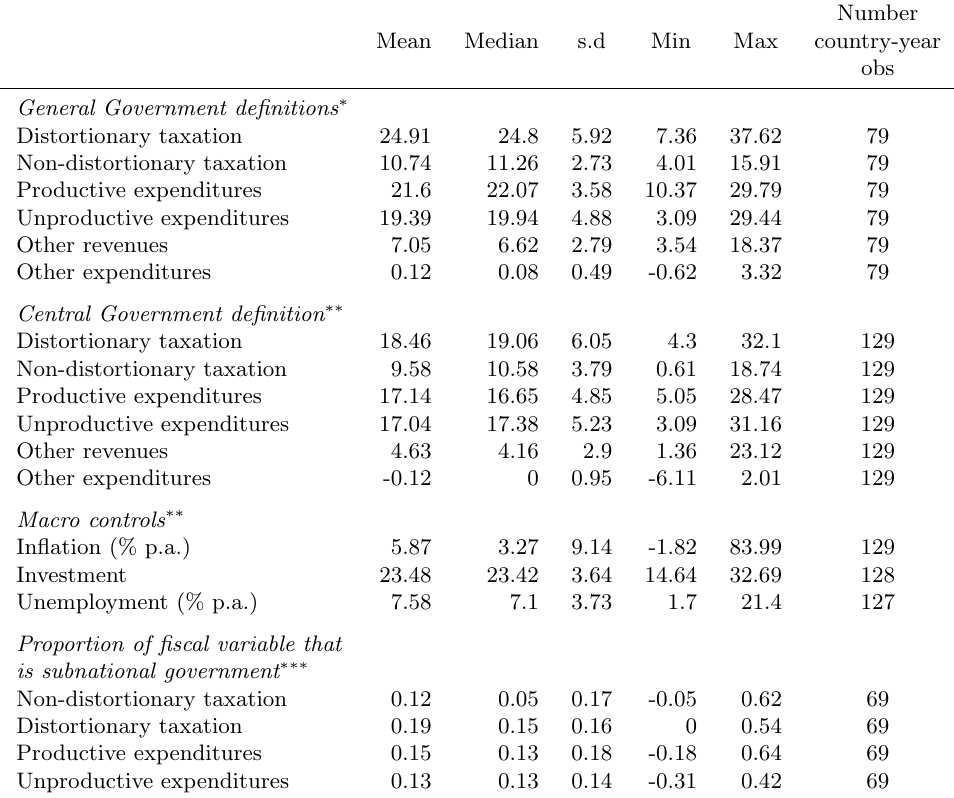
Table A.2: Country-level variable summary